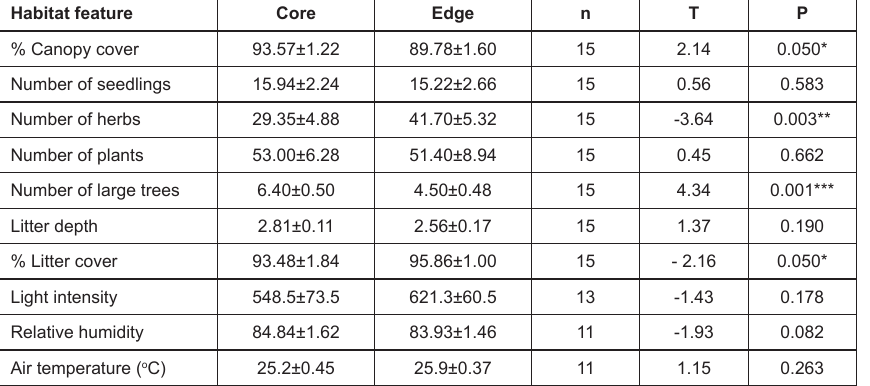
Table 3. Habitat variables (mean ± std. error) in core and edge habitats in the surveyed rainforests. Results of the pairwise t-Tests comparing the mean values of each parameter in core and edge habitats of the individual forests are also shown. Habitat